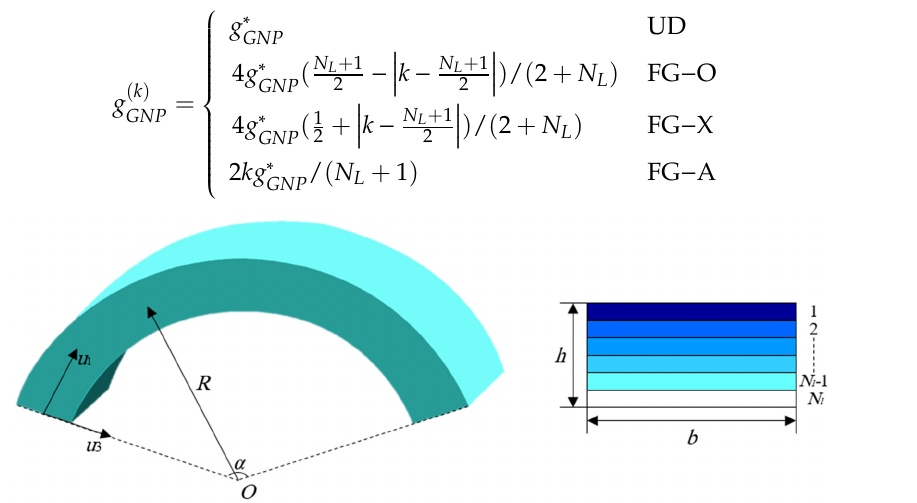
Figure 1. Geometry of graphene nanoplatelets (GNPs) reinforced nanocomposite curved beams.